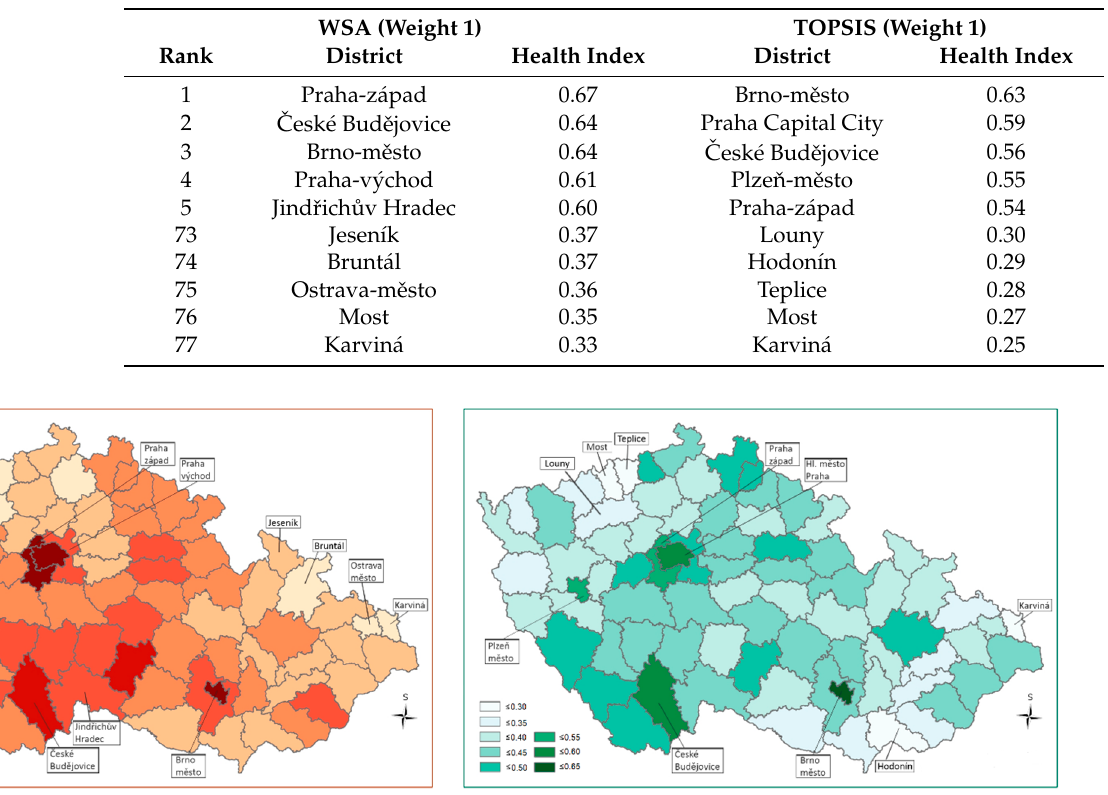
Table 2. Health Index values calculated using the WSA and TOPSIS method with equal weightings given to the areas (selection of the best and worst five districts of the Czech Republic).